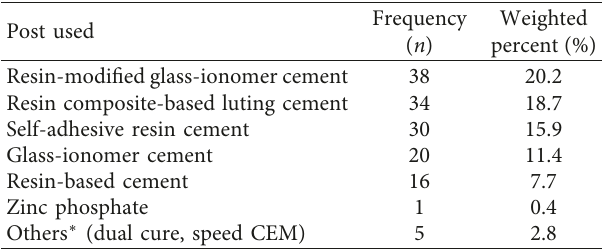
Table 5: Type of luting cements used to cement single zirconia